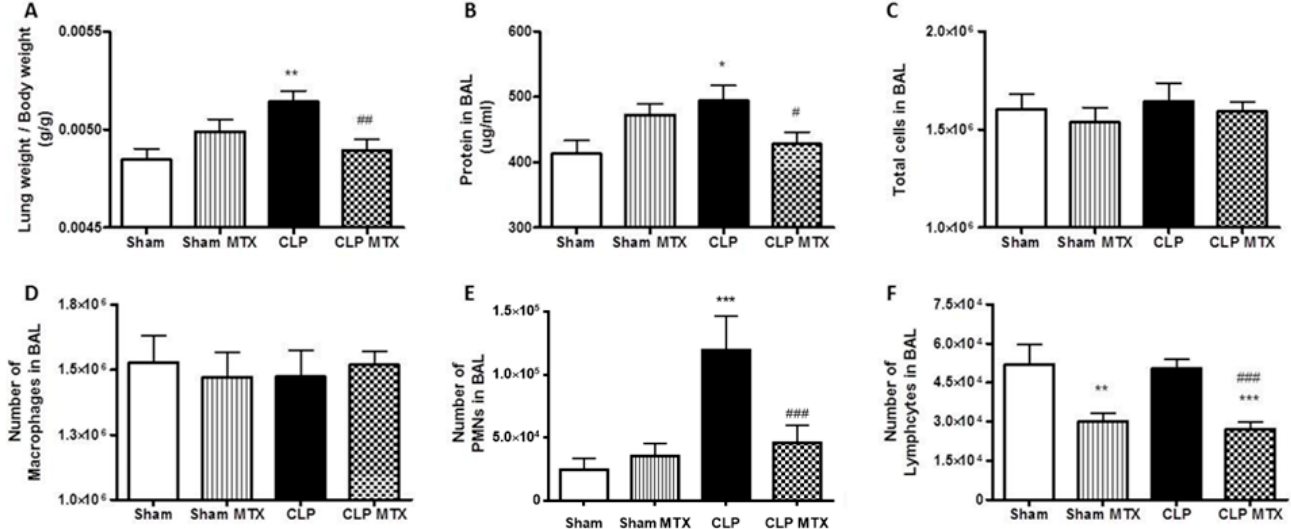
Figure 3. Lung weight and bronchoalveolar lavage analysis (BAL). ( A ) Lung weight corrected by the body weight. ( B ) Concentration of protein in the bronchoalveolar lavage. ( C ) Number of total cells in the bronchoalveolar lavage. ( D ) Number of total macrophages in the bronchoalveolar lavage ( E ) Number of total polymorphonuclear (PMNs) cells in the the bronchoalveolar lavage ( F ) Number of total lymphocytes in the the bronchoalveolar lavage. Data is expressed as mean ± SEM. Sham and Sham + MTX n = 13; CLP and CLP + MTX n = 18. * p < 0.05 vs. Sham group; # p < 0.05 vs. CLP group. **/## p < 0.01; ***/### p <